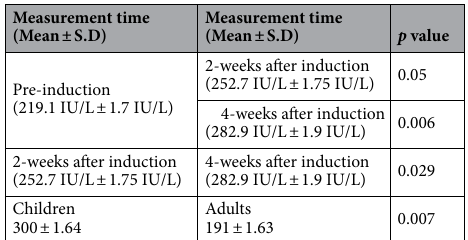
Measurement time (Mean ±